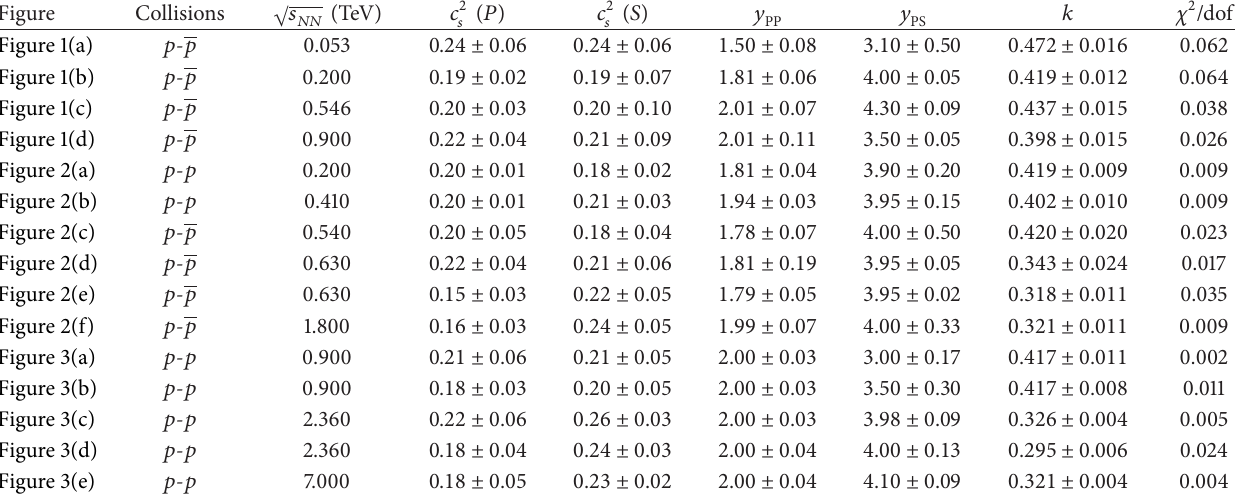
Table 1: Values of 𝑐 2 𝑠 , other parameters, and 𝜒 2 /dof corresponding to the curves in Figures